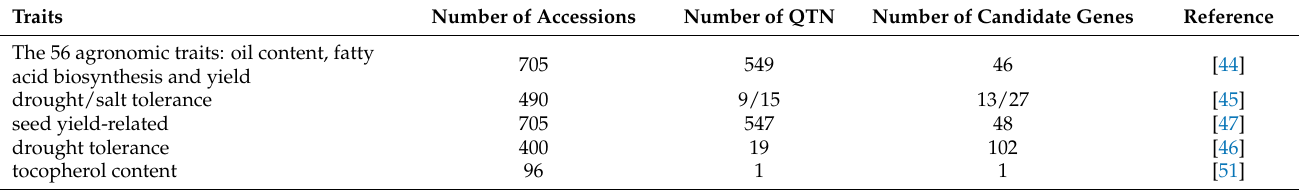
Table 4. The applications of genome-wide association studies in